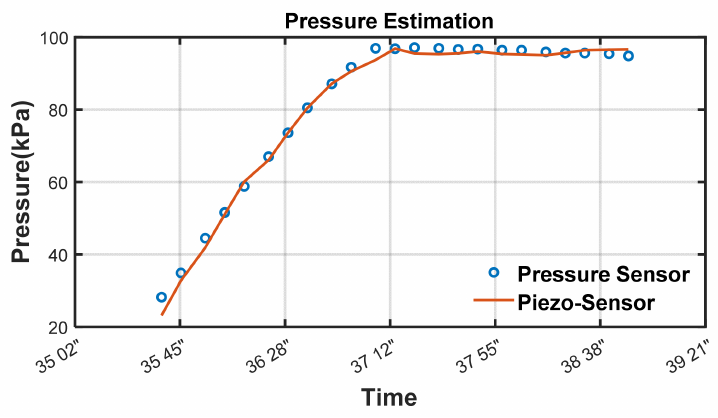
Figure 14. Result of pressure estimation using EMI in the damaged case (test 3).